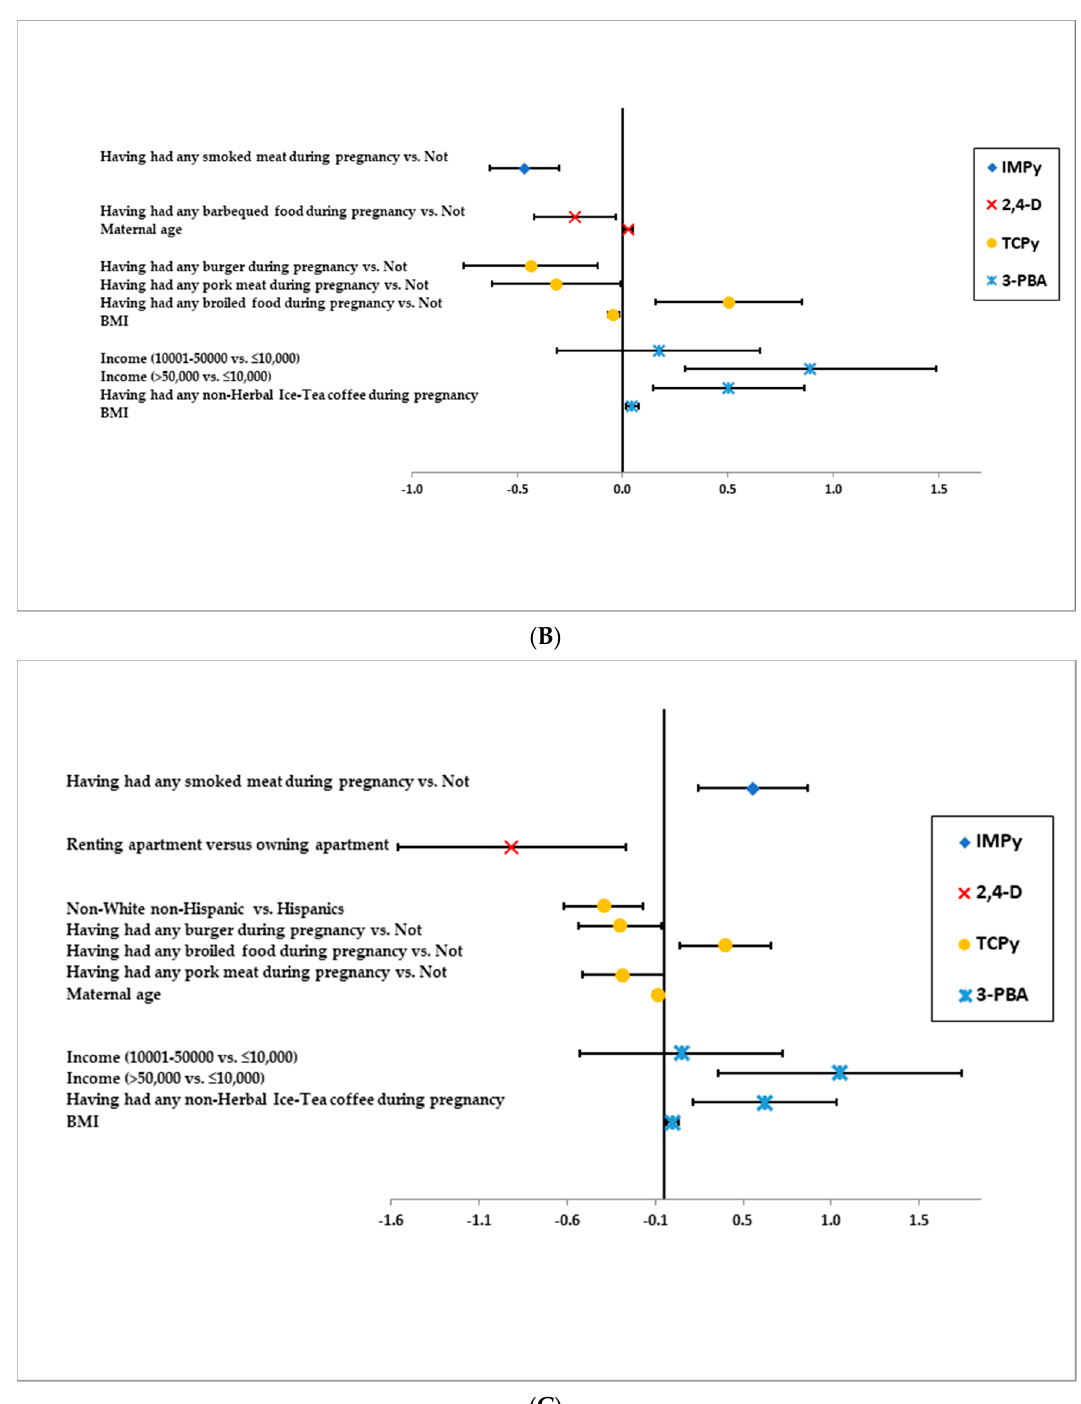
Figure 4. ( A ) . Predictors of Concentrations of organophosphate and pyrethroid pesticides in S/H cohort identified with logistic models ( ≥ median vs. <median) (MODEL A) *. ( B ) . Predictors of Concentrations of organophosphate and pyrethroid pesticides in S/H cohort identified by linear model with < LOD imputed by LOD/ √2 (MODEL B). ( C ) . Predictors of concentrations of organophosphate and pyrethroid pesticides in S/H cohort identified by regression models with lower values censored by LOD (MODEL C). BMI: Body mass Index . * No predictors were selected by backward elimination procedure with the model for TCPy . 3.1. IMPy